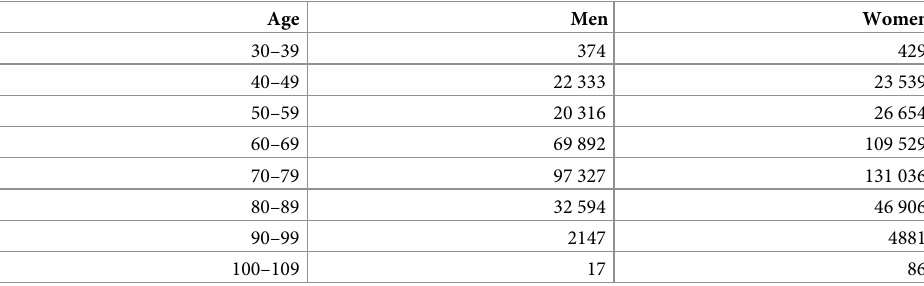
Table 2. Numbers of IDs by age group and